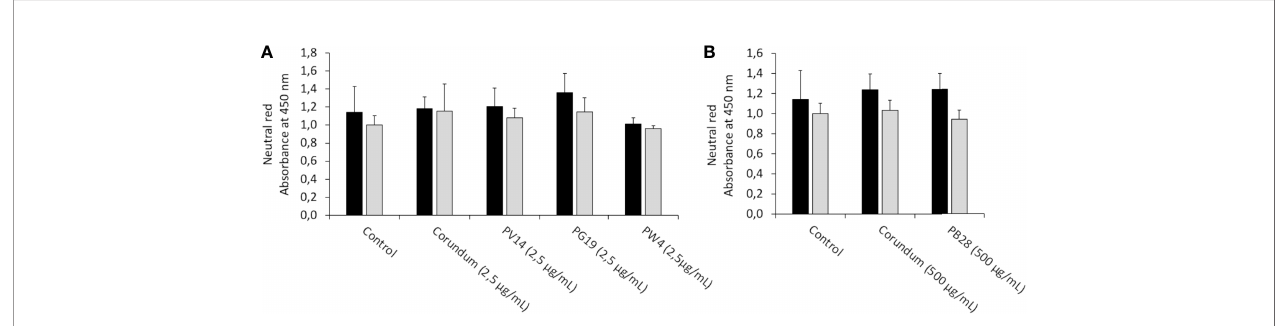
FIGURE 8 | Neutral red uptake. Black bars: acute exposure (24 hours). Grey bars: exposure for 24hours followed by a 3-day post-exposure recovery period. Panel (A) conditions with 2.5 µg/ml of particle suspension. Panel (B) conditions with 500 µg/ml of particle suspension. After elution, the absorbance of the red color released was read at 540